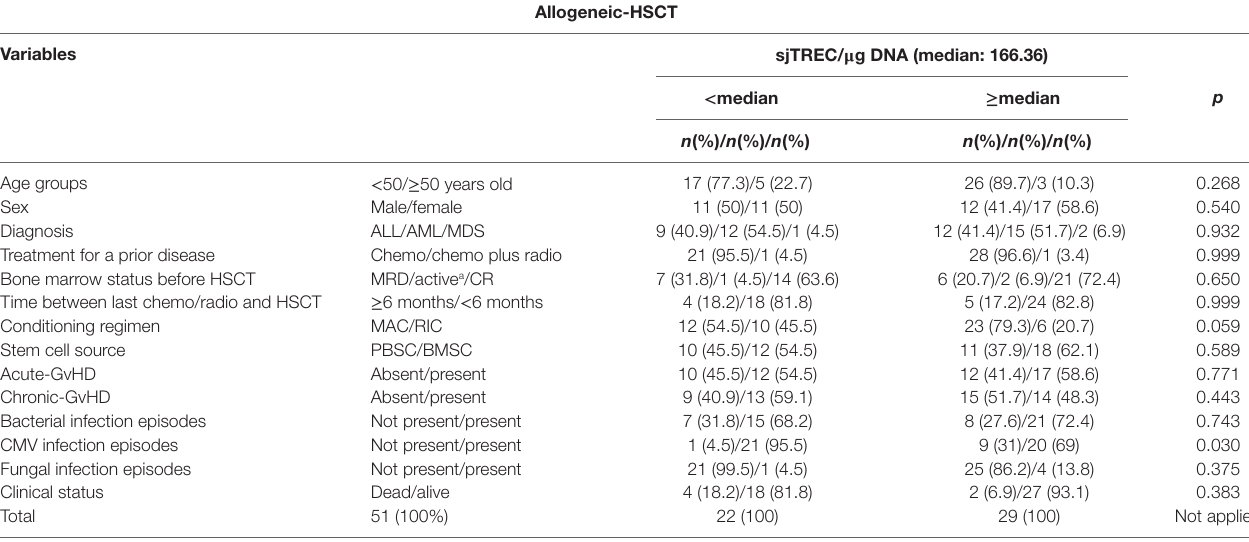
Table 7 | Characteristics of patients 9 months post-allogeneic hematopoietic stem cell transplantation (HSCT).